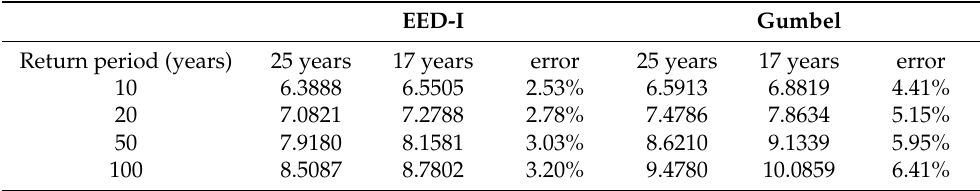
Table 5. Design wave height and error of each model for different time periods. EED-I Gumbel